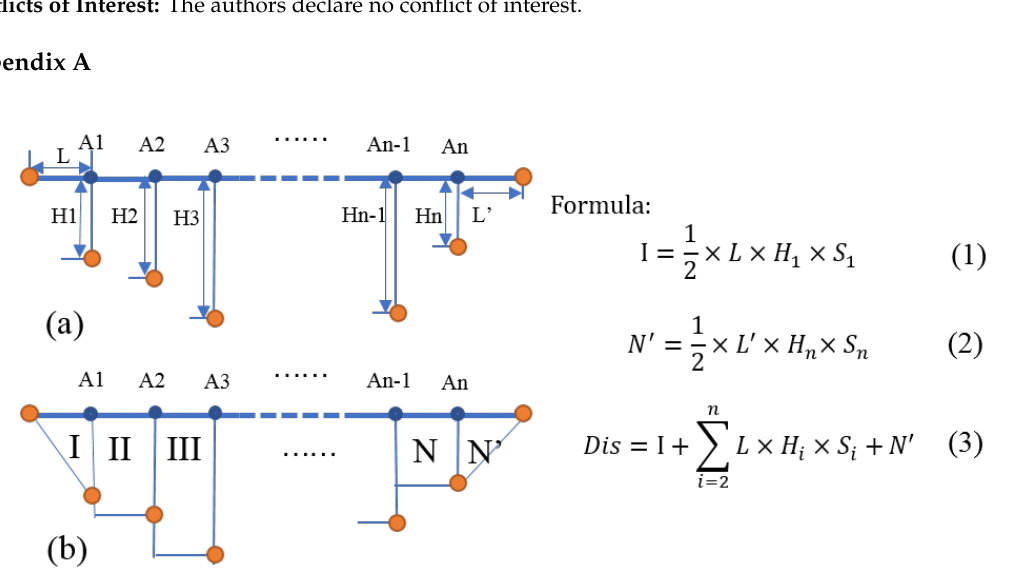
Figure A1. Instantaneous water discharge determination of river cross section at the monitoring point: ( a ) Sketch map for the division of river section; ( b ) Approximate calculation of river section. Starting from river bank, measuring points were set at intervals of L(m) , A i is the measuring points; The depth and flow velocity of the river water was measured at each measuring point, namely H i (m) and S i (m / s) ; I, II, III, ... ., N, N + 1 (m 3 / s) are the instantaneous water discharges of the divided cross sections including two triangles and a set of trapezoids, and the sum of which was taken as the instantaneous water discharge of the river cross section at the monitoring point.